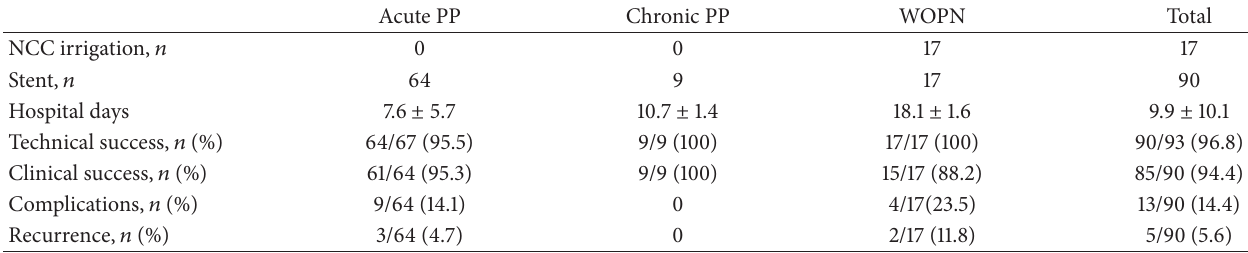
Table 5: Outcomes after endoscopic drainage of PFCs.